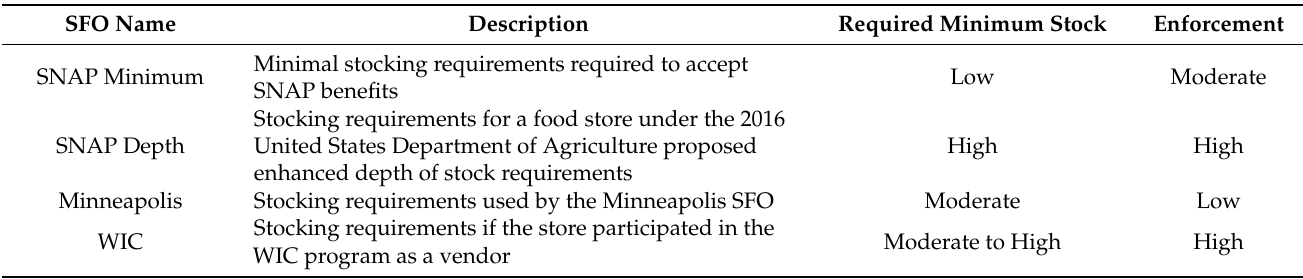
Table 2. Staple Food Ordinance Requirements Table.